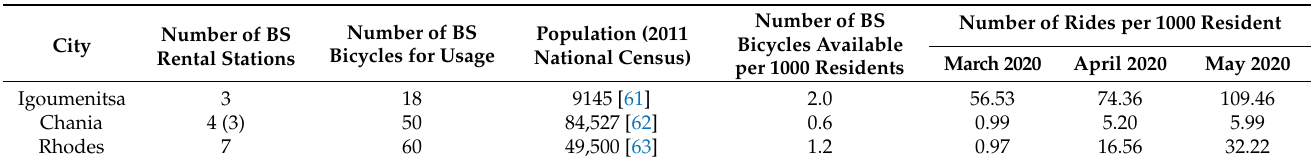
Table 10. Effect of lockdown on number of rides per 1000 residents in the cases of